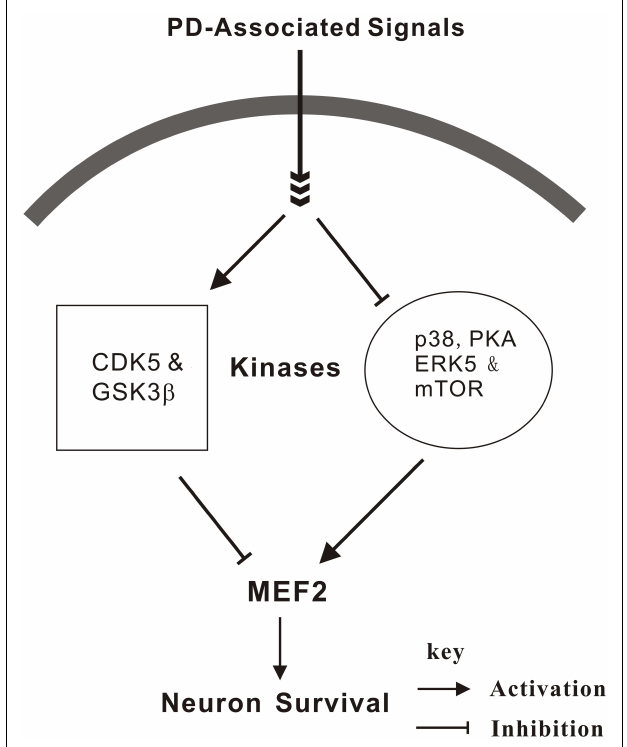
FIGURE 1 | Regulation of MEF2 by kinases in Parkinson’s disease. MEF2 is a key point where survival and death signals converge to exert their regulatory effects. p38, PKA, ERK5, and mTOR have been identified as positive MEF2 regulators whereas Cdk5 and GSK3 β are negative regulators in response to diverse toxic signals relevant to